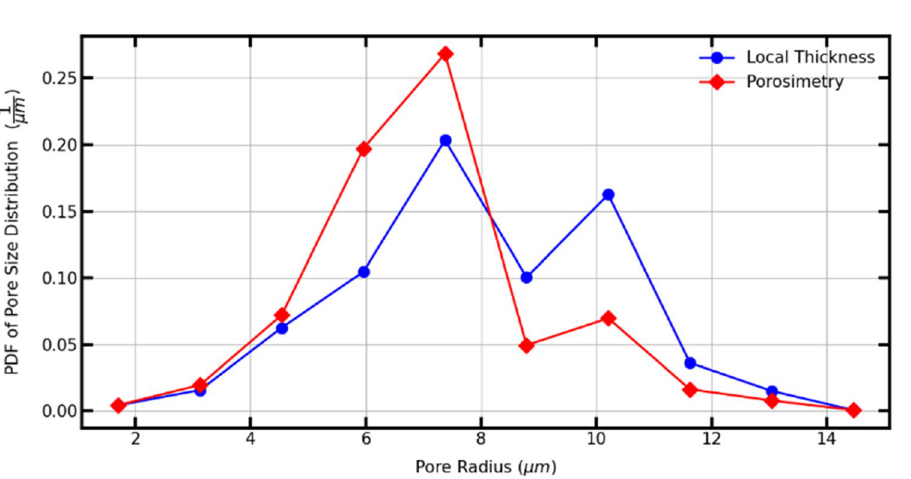
Figure 11. Probability density function (PDF) of pore size distribution for local thickness and porosimetry